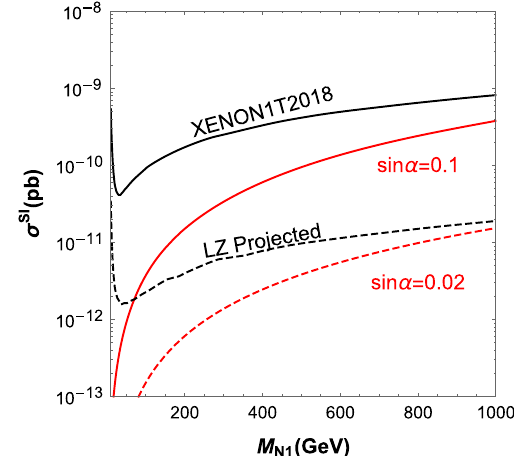
. The black 1 = 500 GeV 1